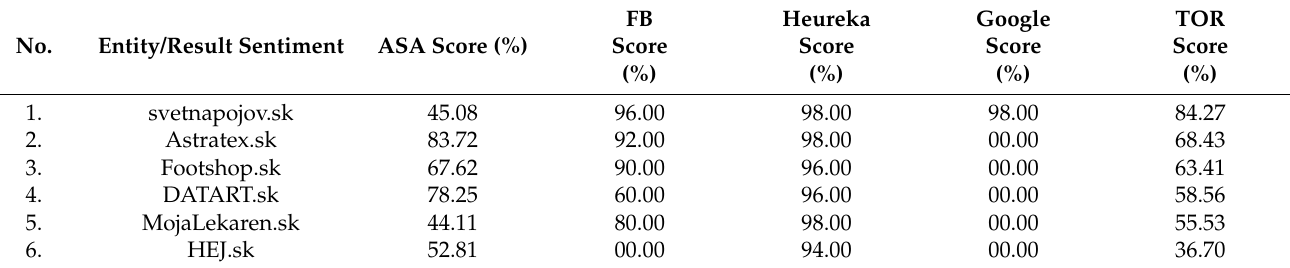
Table 3. Overall (total) online reputation—spring